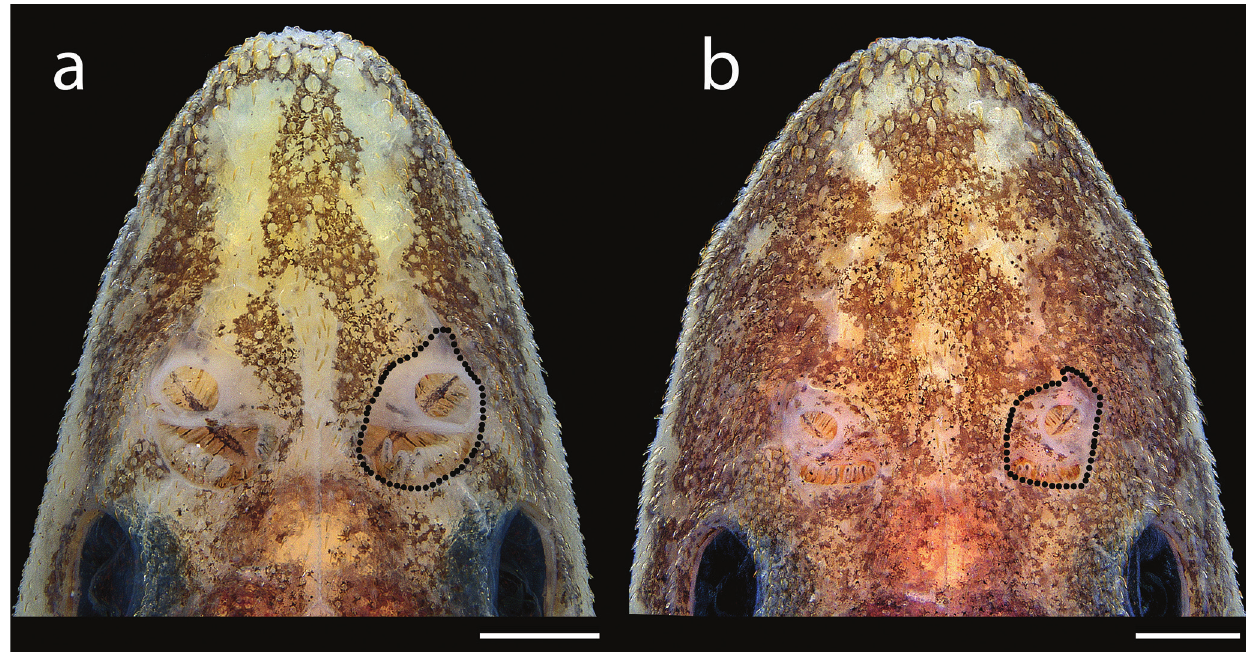
Fig. 3. Snout and sexual dimorphism in size of nares of adults of Curculionichthys hera , MCP 51571, paratypes. a. male; b. female. Scale bars = 1